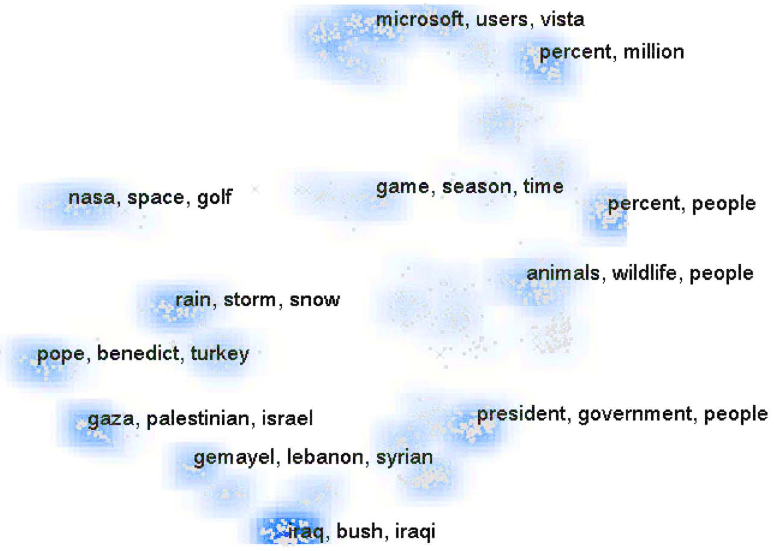
Figure 2. A ‘‘galaxy view’’ of text data created by the IN-SPIRE suite of data visualizations. In-SPIRE uses complex mathematical models in order to discern structure (e.g., clusters) in high-dimensional data.